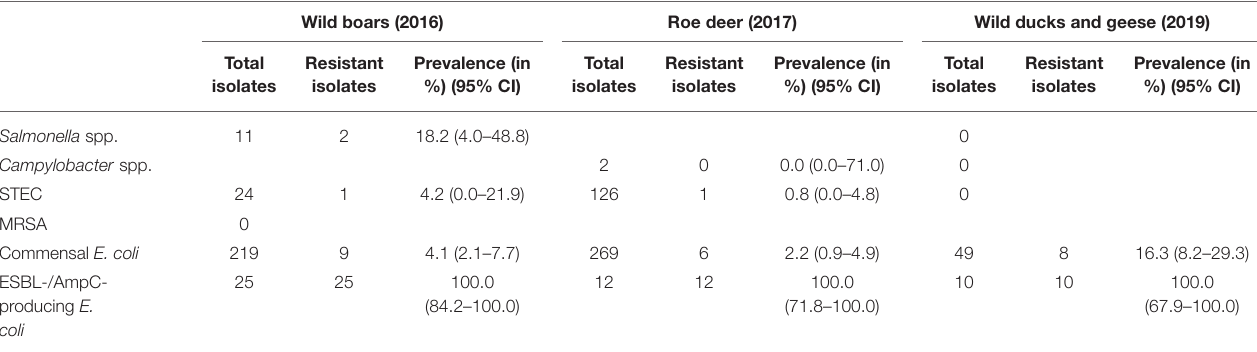
TABLE 4 | Overview of the isolates for which a resistance test was carried out and prevalence and 95% confidence interval (95% CI) of resistant isolates.